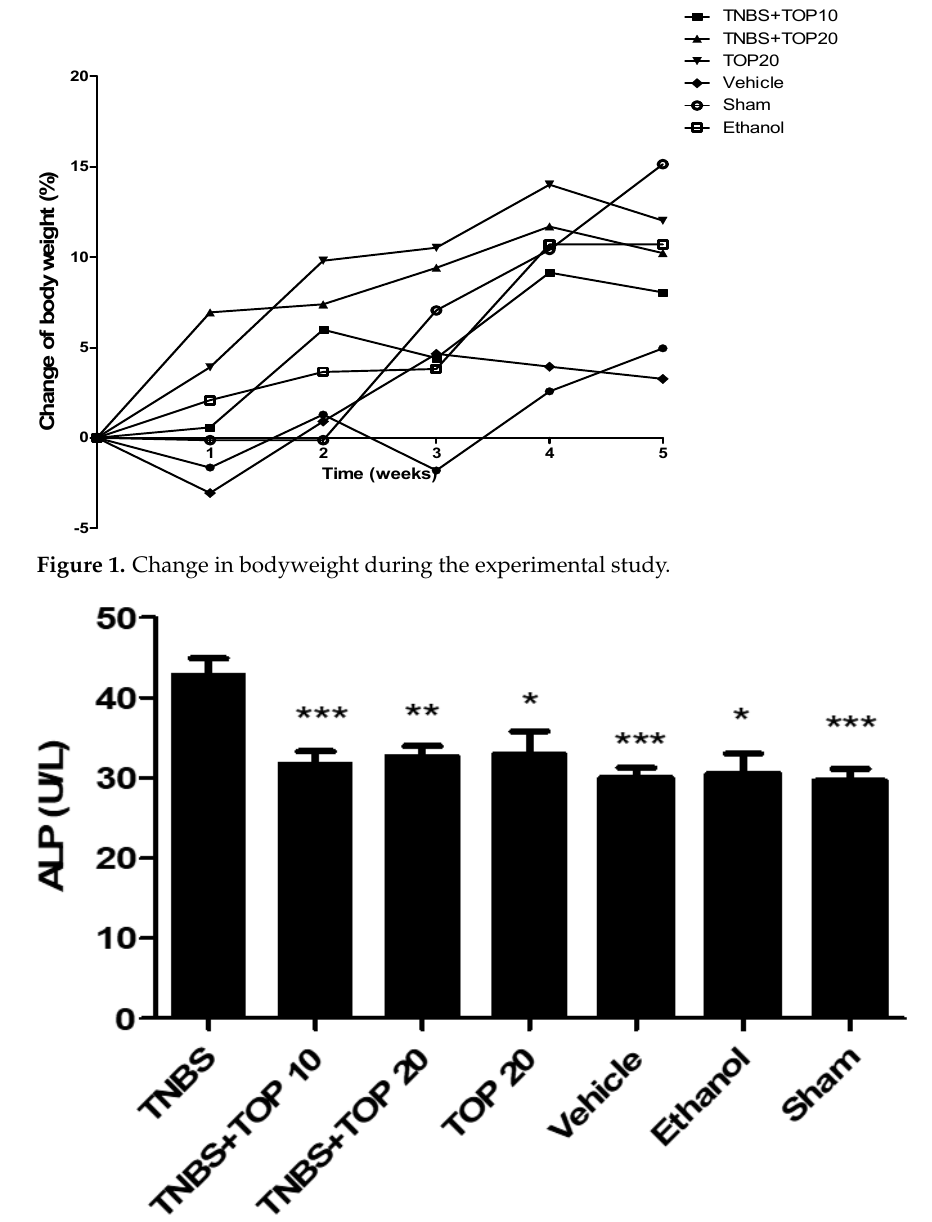
Figure 1. Change in bodyweight during the experimental study.